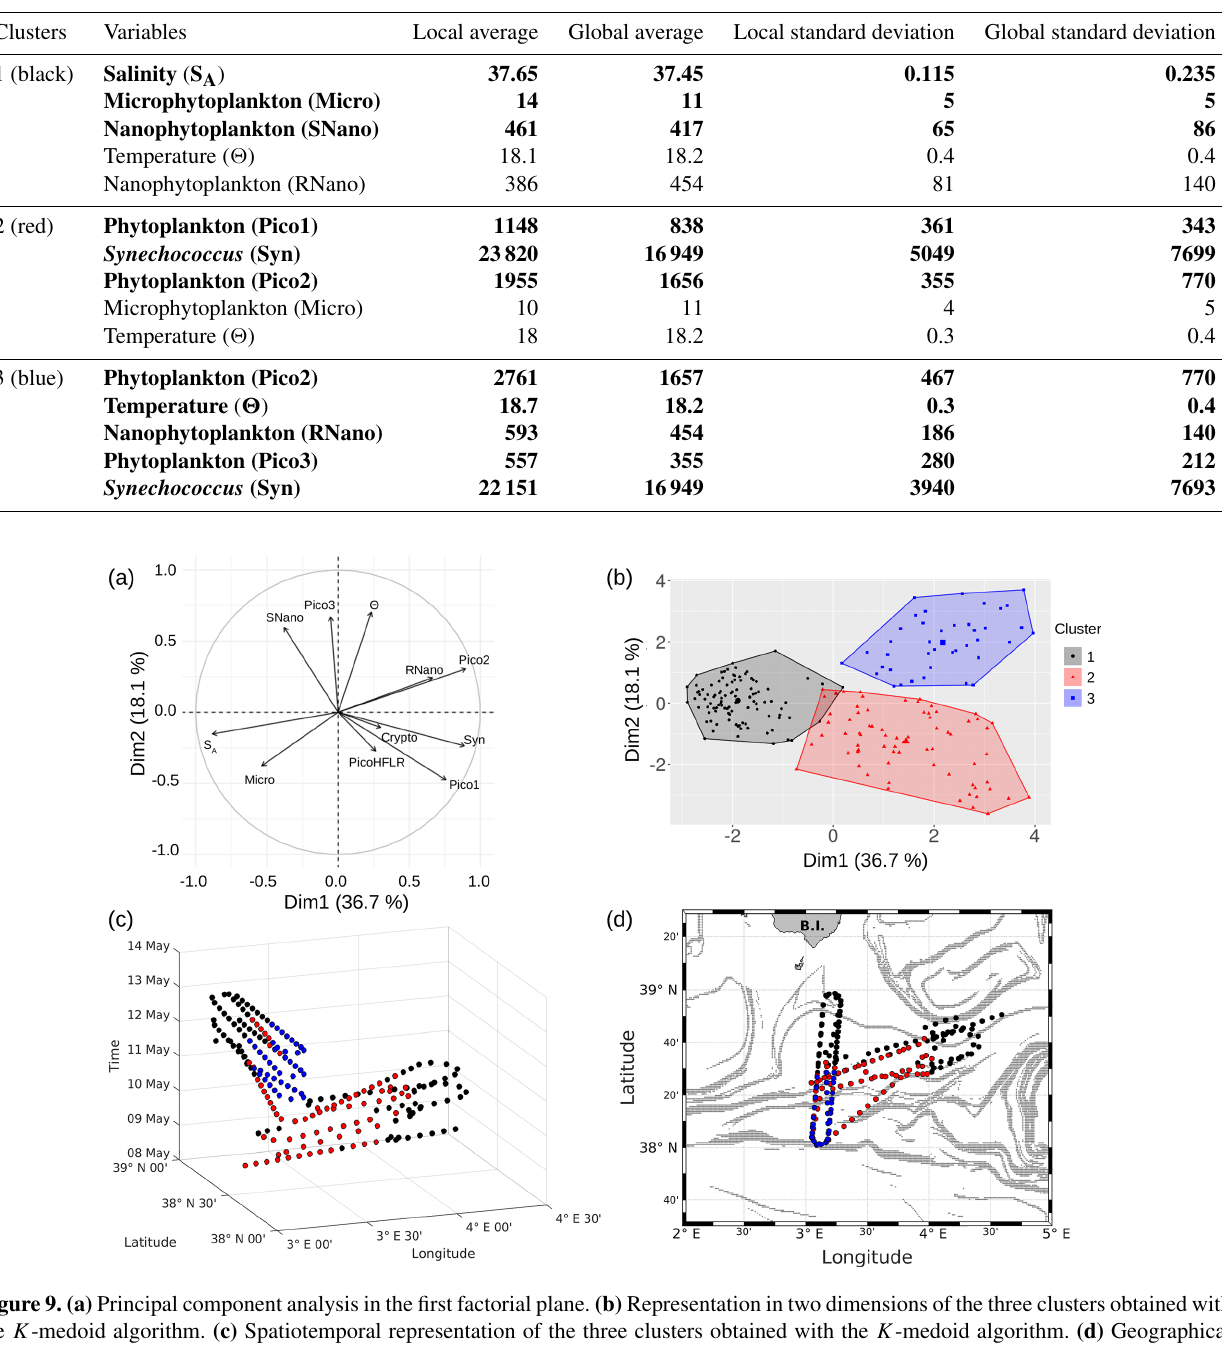
Table 3. Description of the three clusters obtained with the K -medoid algorithm and represented in Fig. 9b, c and d. The local averages (i.e., the average of each variable in a cluster) are compared with the global average (i.e., the average of each variable for the complete data set) to highlight the contribution of each variable to a cluster. Note that only the five most discriminating variables, determined with the standard deviation, are shown for each cluster. Absolute salinity is measured in grams per kilogram, conservative temperature in degrees Celsius and phytoplankton abundances in cells per cubic centimeter. The bold lines represent the variables with the greatest contribution to each cluster (i.e., with local average > global average).